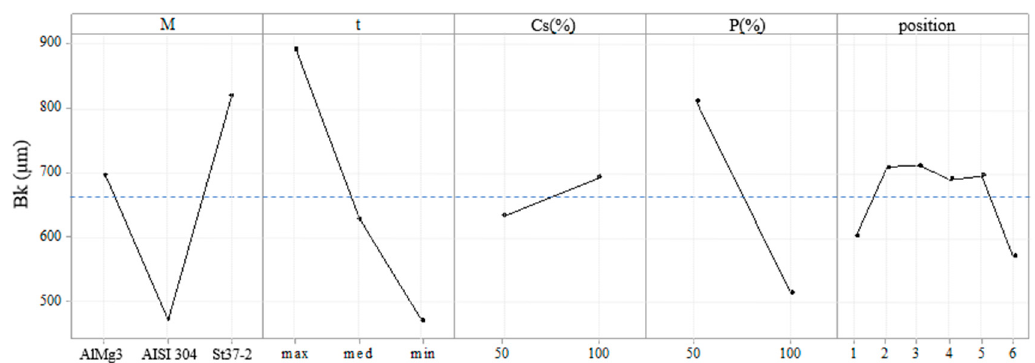
Figure 8. Main effects plot for top kerf width.